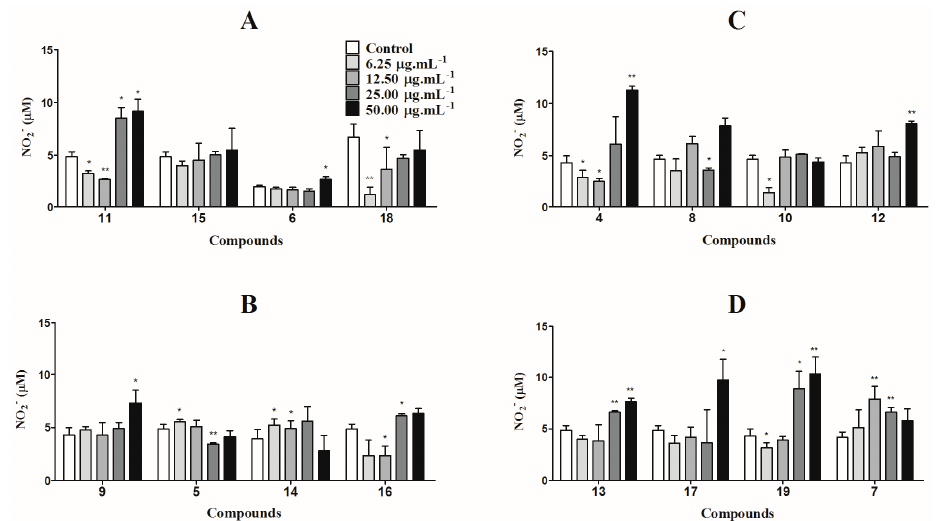
Figure 2. Nitric oxide release by L. amazonensis infected macrophages 24 h after treatment with 1,4-diaryl-1,2,3-triazole derivatives ( 4 – 19 ) of the neolignans 1 – 3 . Bars represent the mean ± SD of six replicates. * p ≤ 0.05, ** p ≤ 0.01, for the different concentrations compared to untreated cells (control) (Student’s t -test). ( A ) trimethoxy series; ( B ) dimethoxy series; ( C ) methoxy series; ( D ) methylenedioxy series (substitution pattern of ring A).